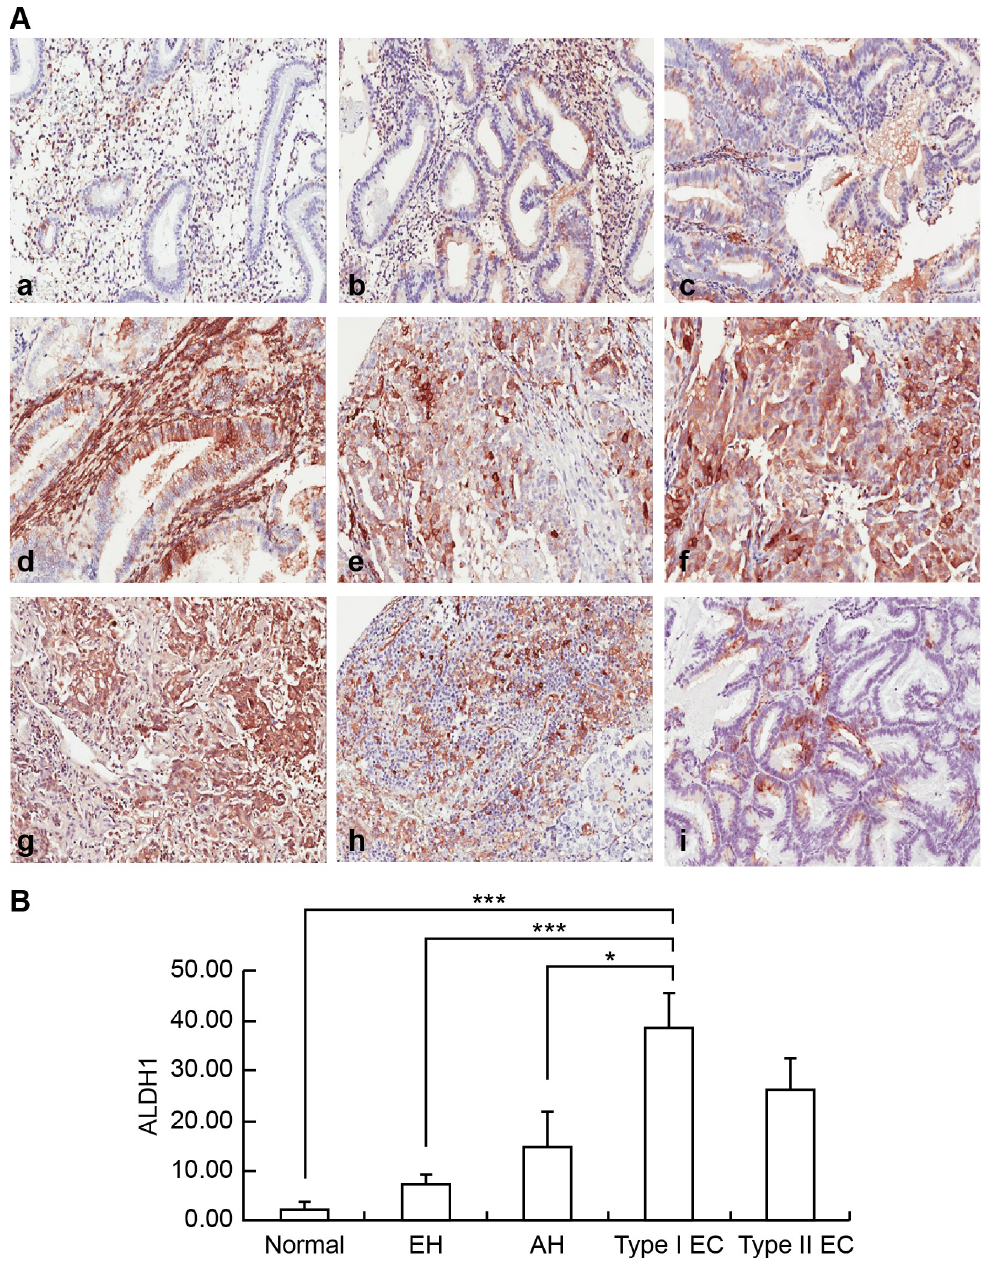
Fig 1. Examples of immunohistochemical staining for ALDH1 in endometrial lesions. (A) Immunohistochemical examination of ALDH1 expression in normal endometrium (a), EH without atypia (b), AH (c), grade 1 EmAC (d), grade 2 EmAC (e), grade 3 EmAC (f), SC (g), CC (h), and MC (i). (B) Semiquantitative Comparison of ALDH1 Immunostaining Scores Between Normal Endometrium, EH without Atypia, AH, and Type I, and Type II EC. Normal endometrium vs. Type I EC, p < 0.001 ��� ; EH without atypia vs. Type I EC, p < 0.001 ��� ; AH vs. Type I EC, p < 0.05 � . ALDH1 and CD44 expression with age, FIGO stage, or EC subtype, and there was only a mar- ginally significant association with nuclear grade (p = 0.048). It appears that those with both ALDH1 and CD44 expression more than median had a higher proportion of type II EC (CC,